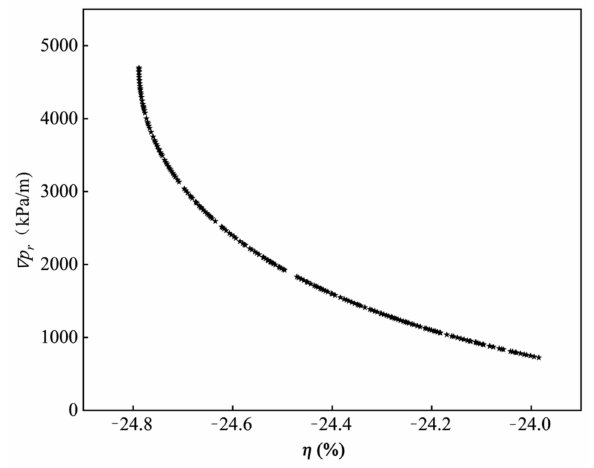
Figure 6. Pareto solution set ( ∇ p r - η ).